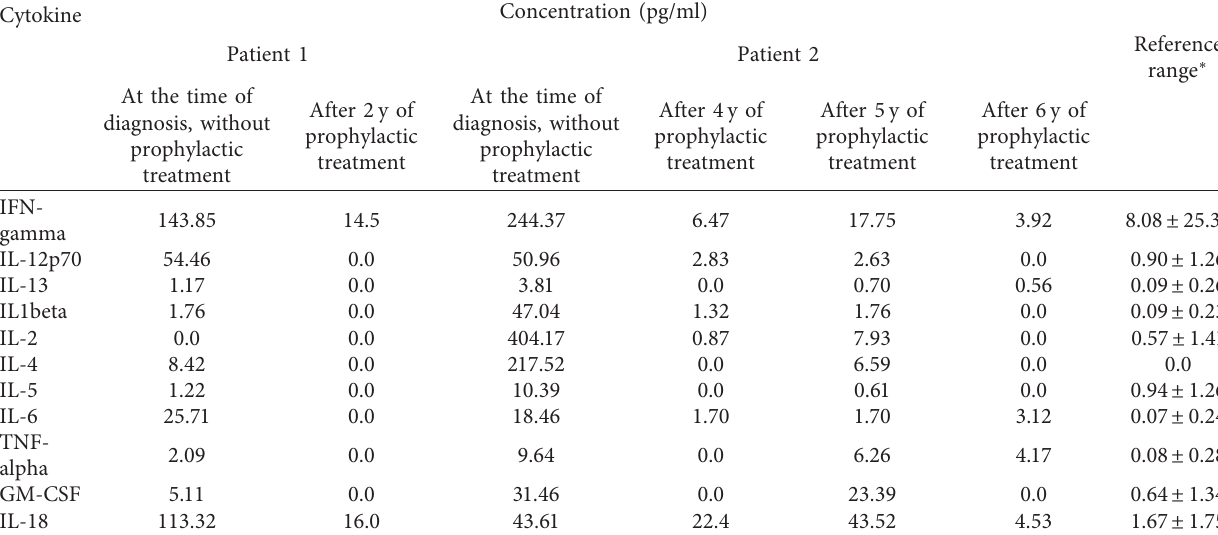
Table 4: Serum levels of cytokines investigated in Patients 1 and